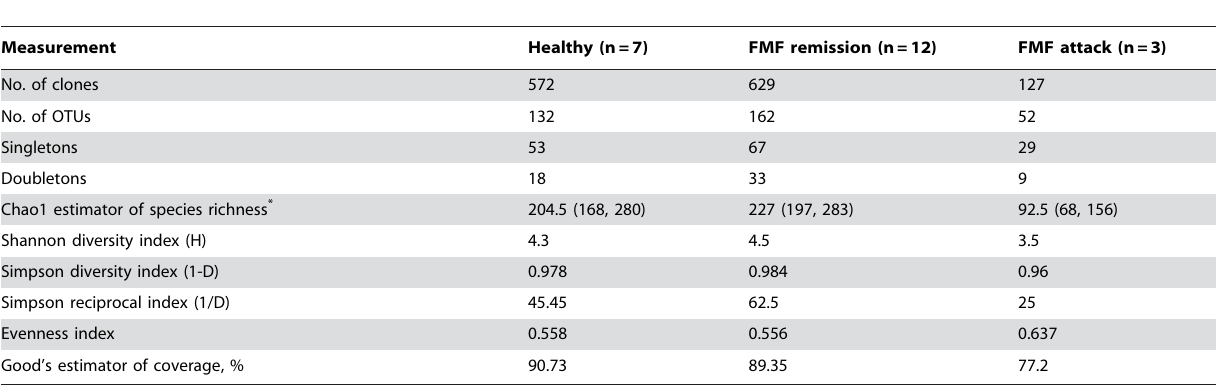
Table 4. Indices of diversity, richness and evenness and library coverage for 16S rRNA gene libraries.